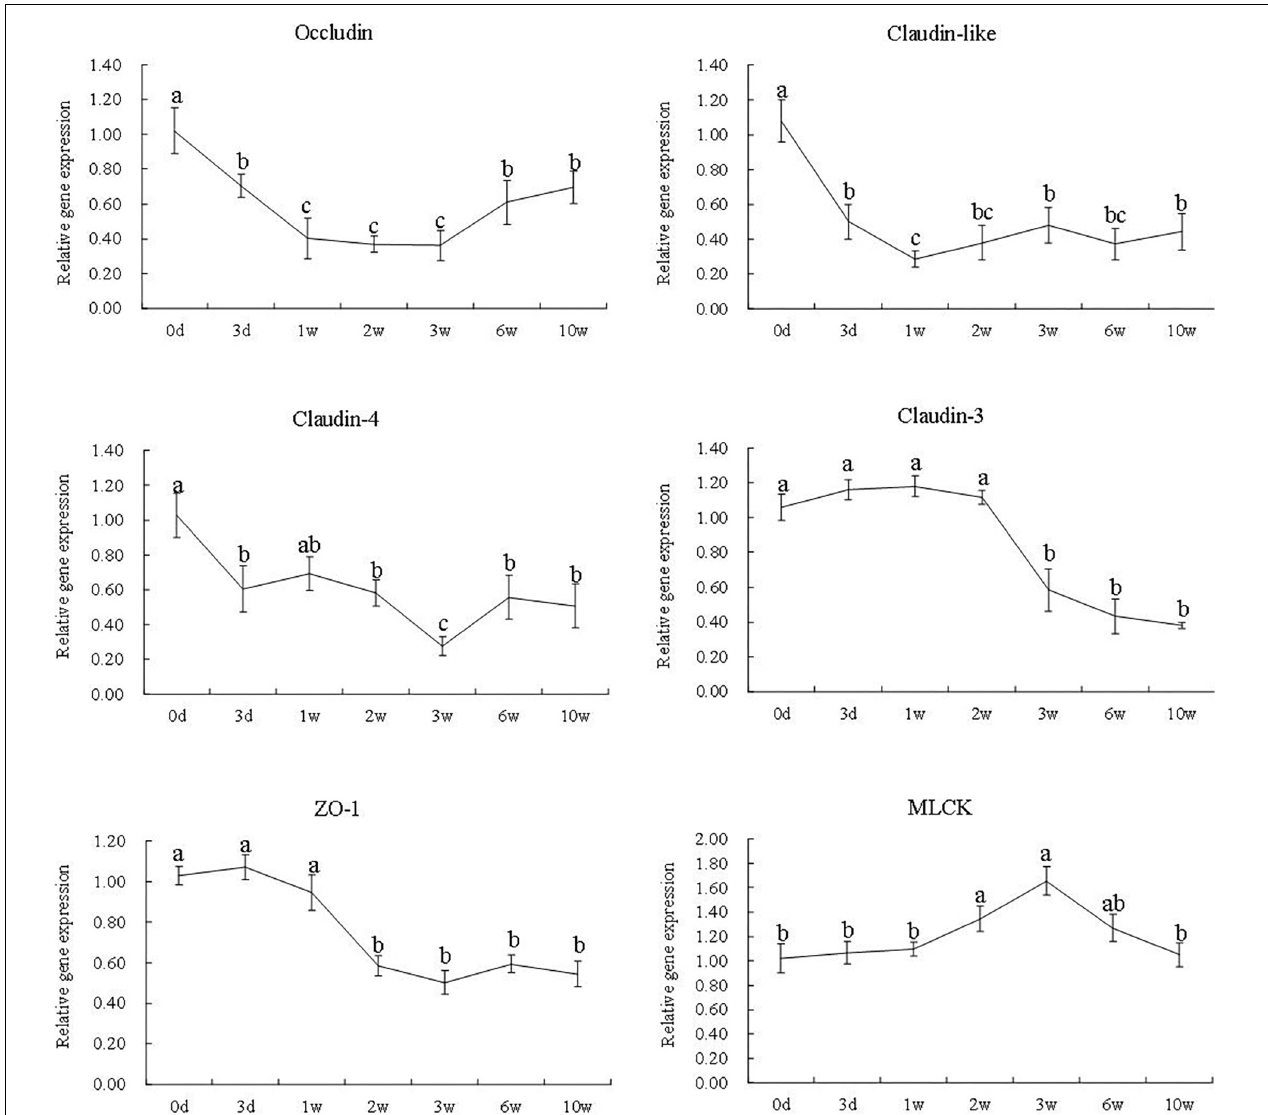
FIGURE 5 | The gene expression of occludin, claudin-like, claudin-4, claudin-3, ZO-1, and MLCK at different time points in the 7S&FM group. Results are expressed as means ± standard error. Different letters above the broken lines denote significant ( P < 0.05) differences at different time